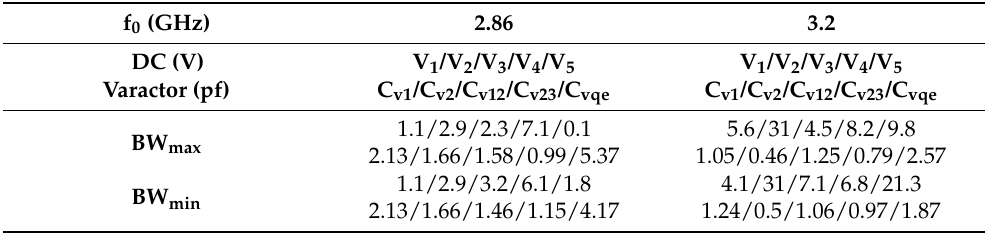
Table 2. Load-voltages of